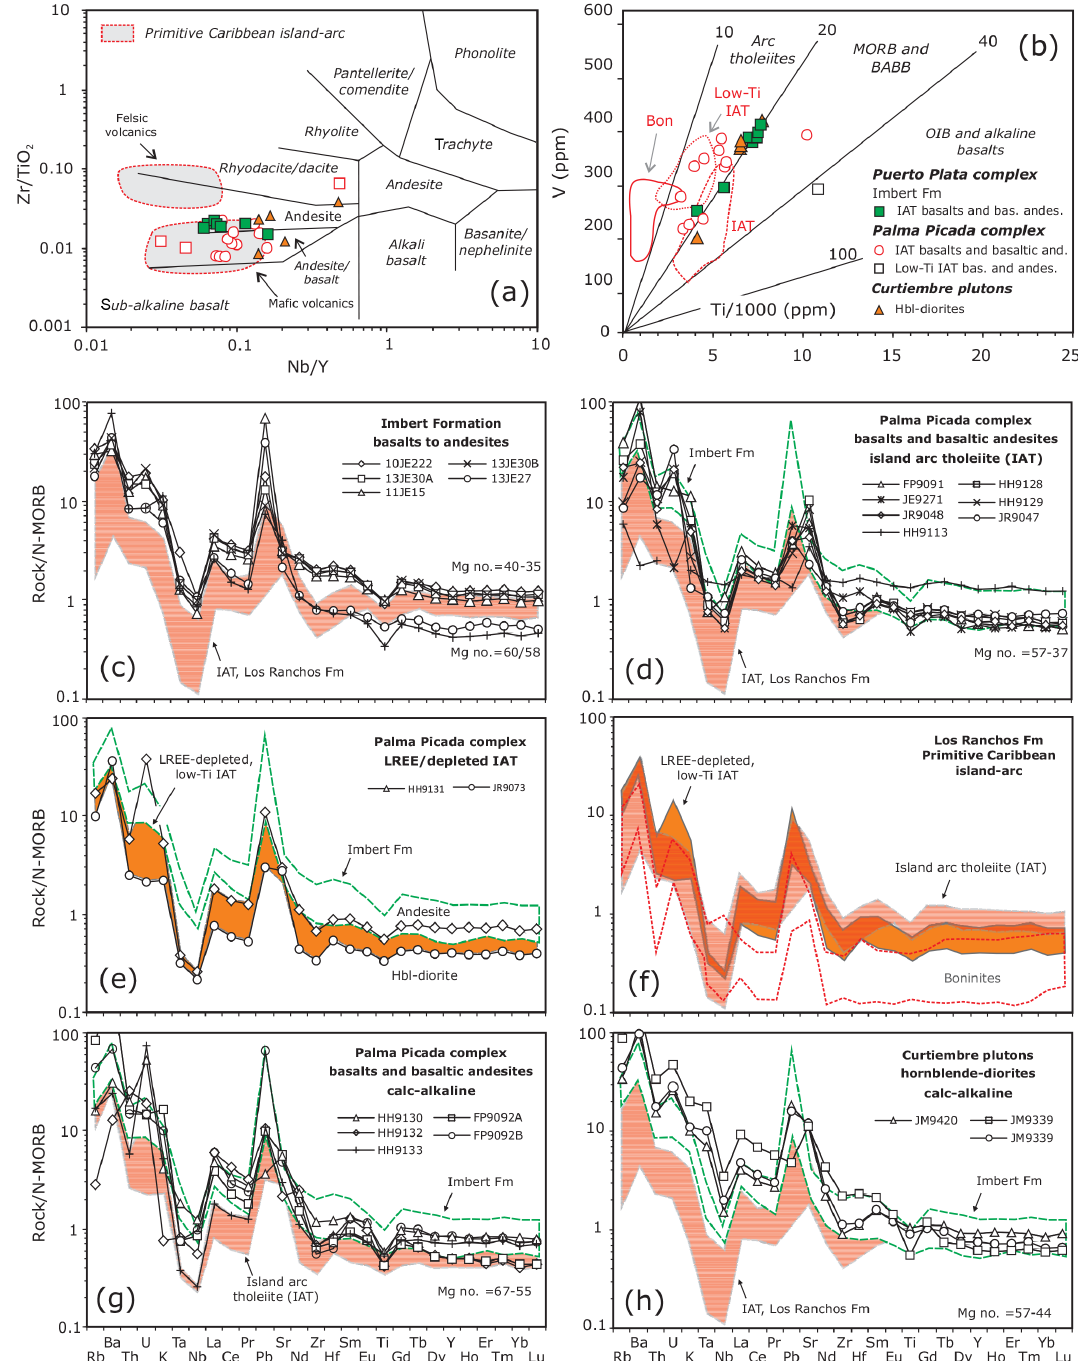
Figure 8. (a) Nb / Y vs. Zr / TiO 2 diagram and (b) Ti–V diagram for rocks from the Imbert Fm, Palma Picada complex, and Curtiembre plutons. MORB-normalized extended trace-element plots for volcanic rocks of the (c) Imbert Fm, (d, e, g) Palma Picada complex, and (h) Curtiembre plutons. The diverse geochemical groups of Lower Cretaceous igneous rocks in Hispaniola shown in (f) are (Escuder-Viruete et al., 2006, 2010): IAT, normal island-arc tholeiites; low-Ti IAT, LREE-depleted island-arc tholeiites; and Bon, boninites. See text for